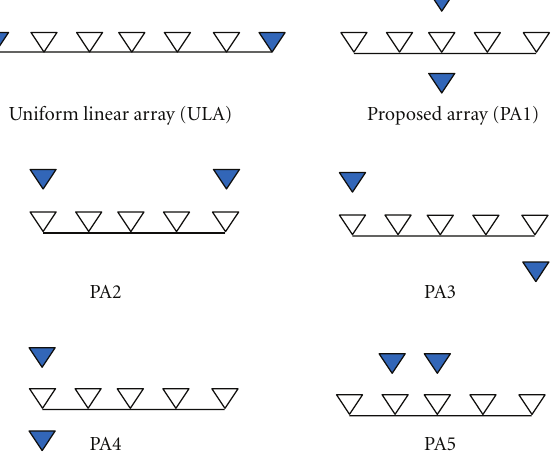
Figure 1: ULA and proposed array (PA)